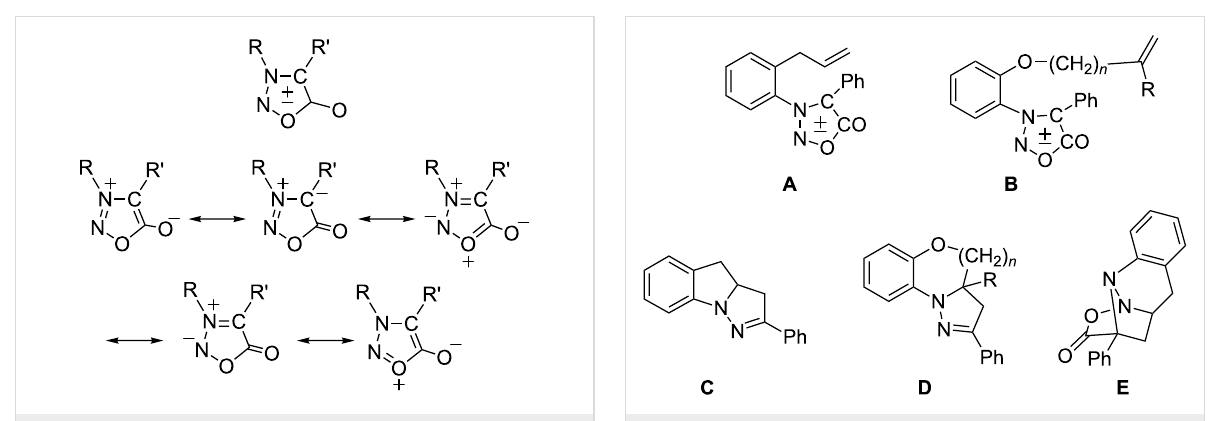
of a heterostilbene [17] ( 1 , Figure 3) or is directly attached at the ortho position to the stilbene 2 [21-23]. Upon photolysis